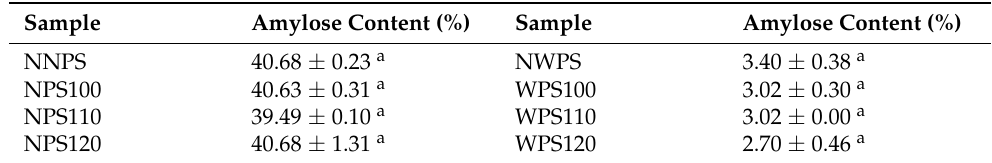
Table 1. The amylose content in the samples.